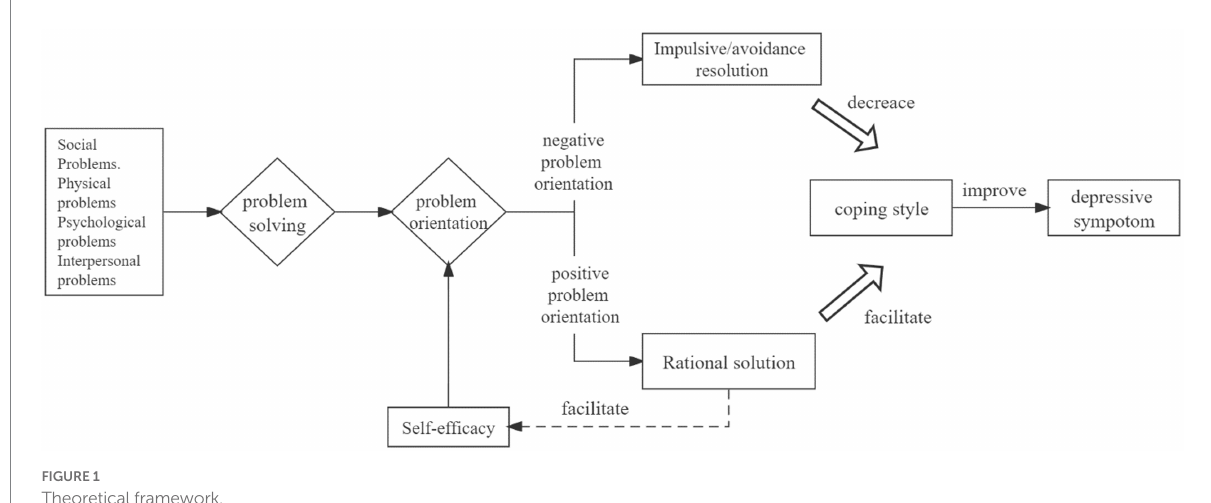
FIGURE 1 Theoretical